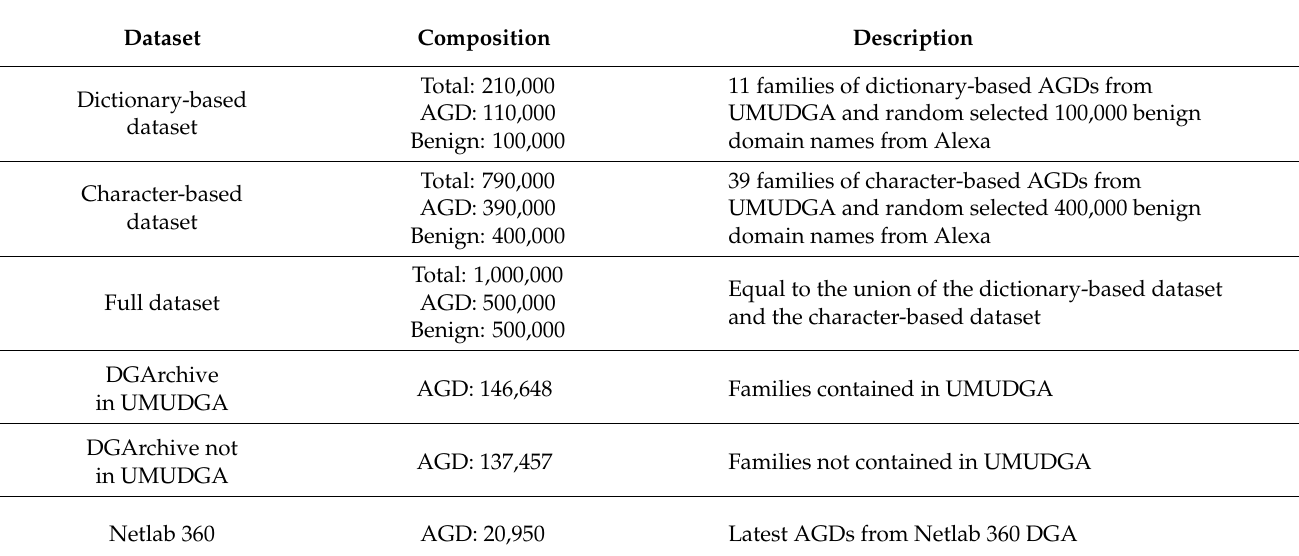
Table 2. Descriptions of